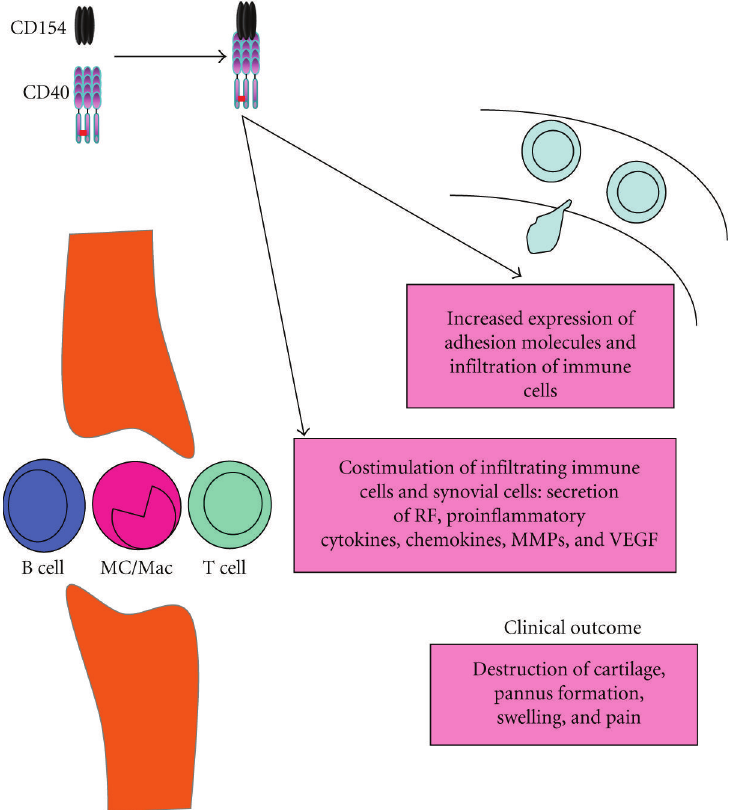
Figure 4: Biological role of CD154 in RA. CD154 contributes to the pathogenesis of RA by stimulating expression of adhesion molecules, production of RF, release of inflammatory mediators including cytokines, chemokines, MMPs, and